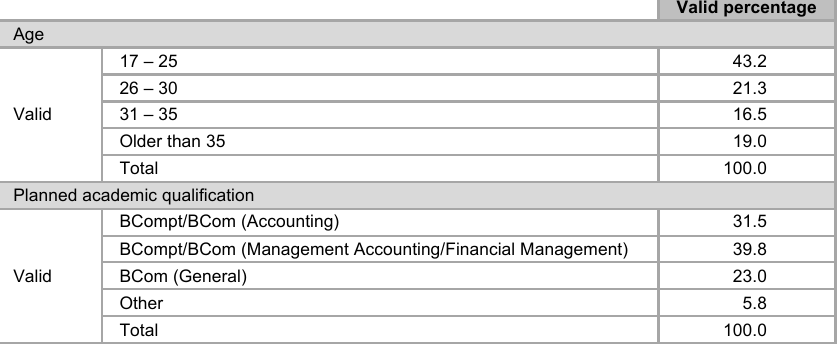
Respondents’ age distribution and planned academic